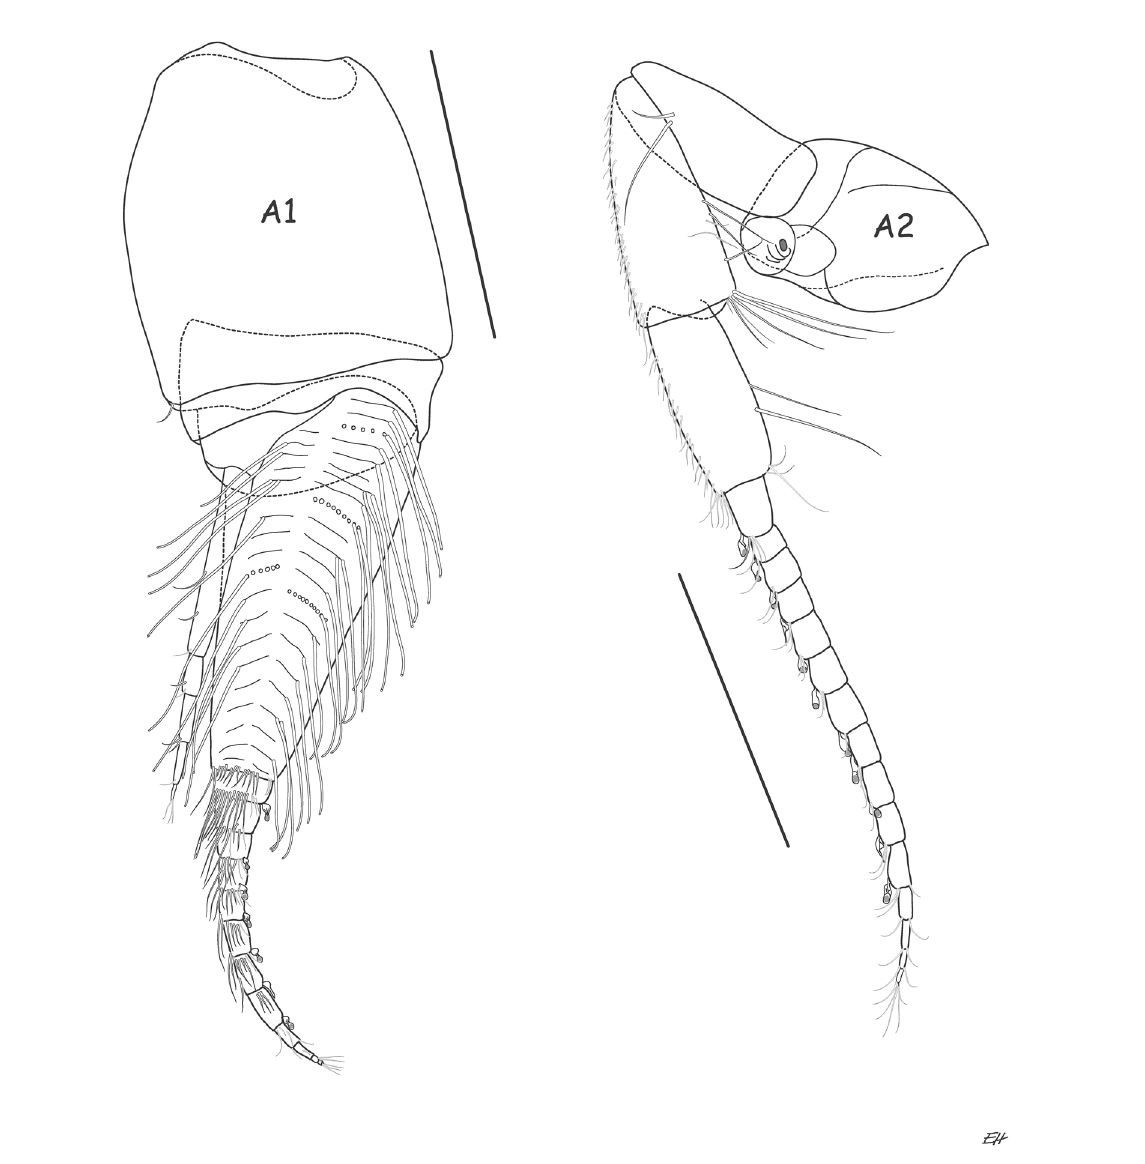
Fig. 5. Abyssorchomene abyssorum (Stebbing, 1888), holotype, ♂, 7.5 mm (BMNH 1889.5.15.23). Most aesthetascs omitted from A1 callynophore. Scale bars = 0.5